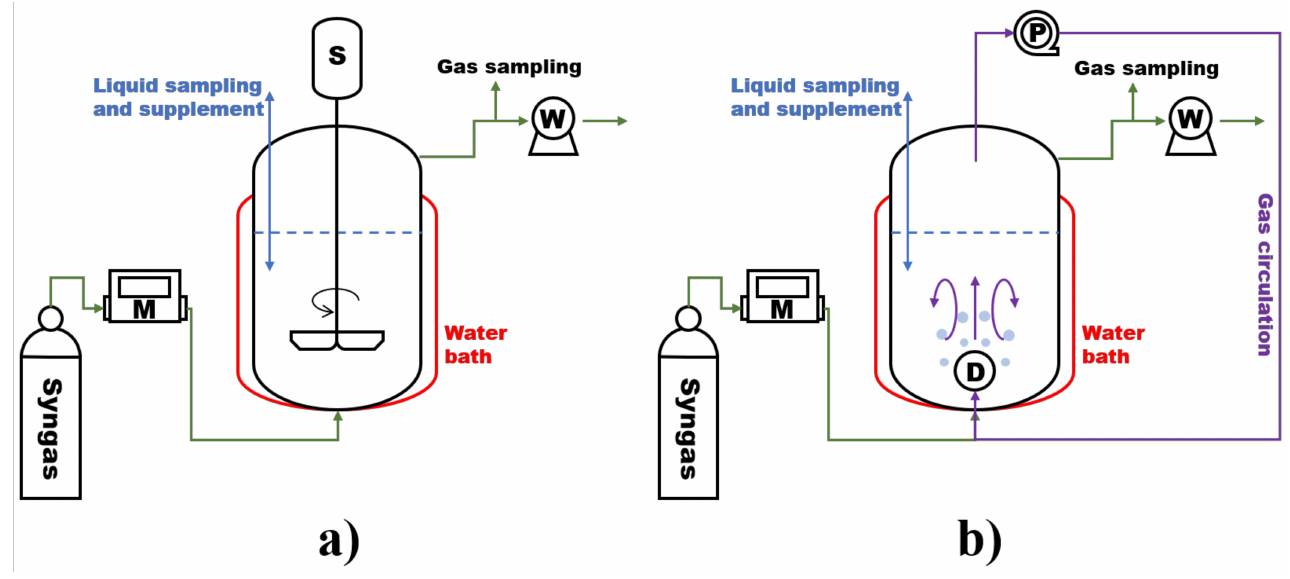
Figure 2. Schematic diagram of ( a ) the continuous stirred tank reactor and ( b ) the bubble column reactor with gas